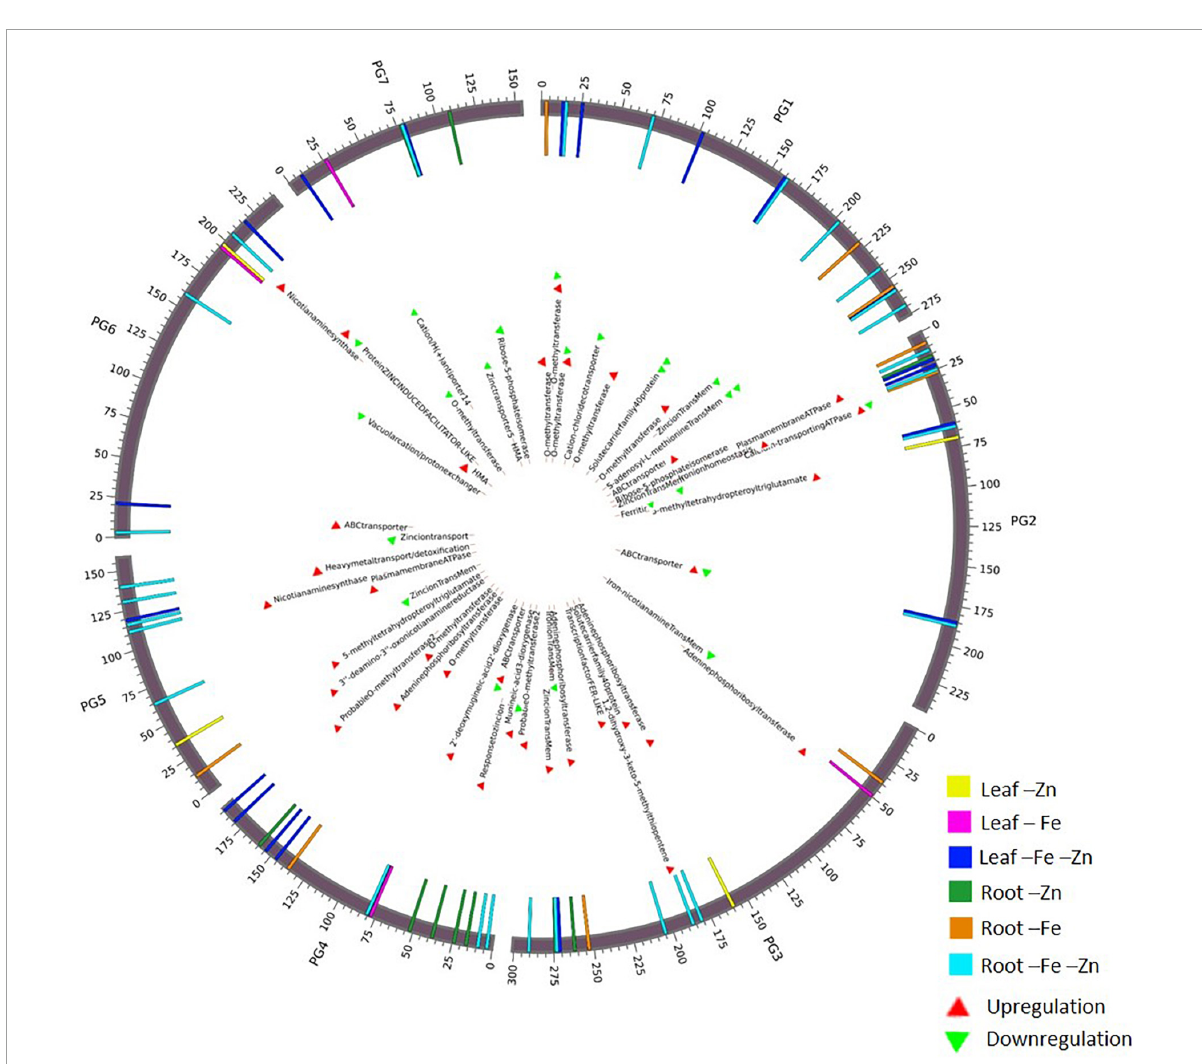
FIGURE3 Circos plot representing important Fe and Zn homeostasis-related genes along with the differential expression patterns in pearl